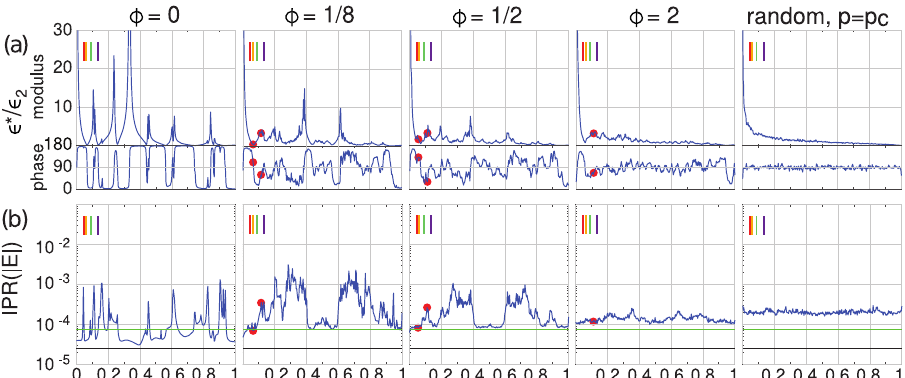
Fig. 3 Frequency pro fi le of the spectral measure and eigenvector localization. Composite microgeometry and fi elds, spectral measure μ , and eigenvector inverse participation ration (IPR) plotted for various values of the Moiré twist angle θ , for 0° ≤ ϕ ≤ 2°, scale parameter r ¼ size 73 in ( a ) to show detail and of size 199 in ( b ) and ( c ). The color bars in the upper left of the panels are for reference and indicate Re s ð ω Þ corresponding to impedances throughout the optical frequency range for a Drude model of a gold/vacuum composite. ( a ) Composite microgeometry and fi eld intensity. Cool and warm colors correspond to near-zero and large values of electric fi led ∣ χ 1 E ∣ or displacement ∣ χ 1 D ∣ , respectively, with color bar at the top showing the saturated linear scale. ( b ) Masses m j of measure μ plotted versus eigenvalues 0 ≤ λ j ≤ 1 of the matrix G . Red dots indicate the largest masses, used as indicators in ( c ) below. ( c ) IPR values for the eigenvectors v j of G , IPR( v ), plotted versus λ j . Green and black horizontal lines indicate IPR values for Gaussian orthogonal ensemble (GOE) vectors and completely extended vectors, 3/ N 1 and 1/ N 1 , respectively. These quantities for the random percolation model at the percolation transition, p = p c = 1/2, are shown in the rightmost panels for comparison.